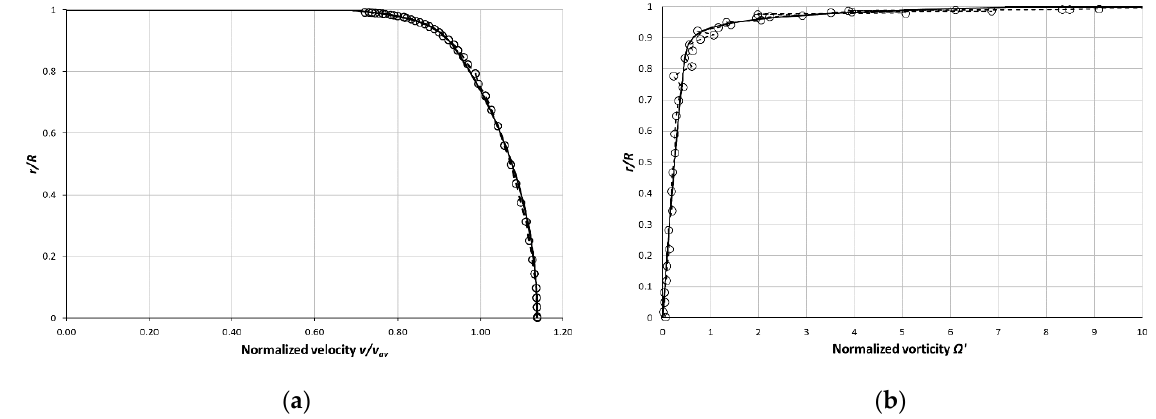
Figure 21. The experimental data (PSP) for Re = 13,598,000 comparison with predicted mean velocity profile. The empirical formulas for exponents K and N are used only. Dashed line with circles represents the experimental data, the solid line is the analytical profile. ( a ) Normalized mean velocity profile, ( b ) Normalized vorticity distribution analytical.